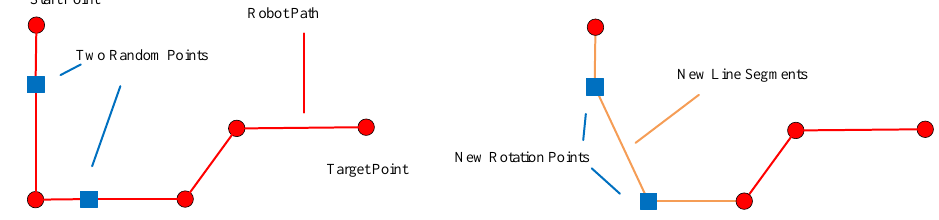
Figure 8. The smoothness operator is presented. In the left sub-figure, two free points are randomly generated on the two line segments where the maximum turning angle is located and are represented by blue squares. Then the intersection of the two segments is replaced with these two points. The right sub-figure shows the generated